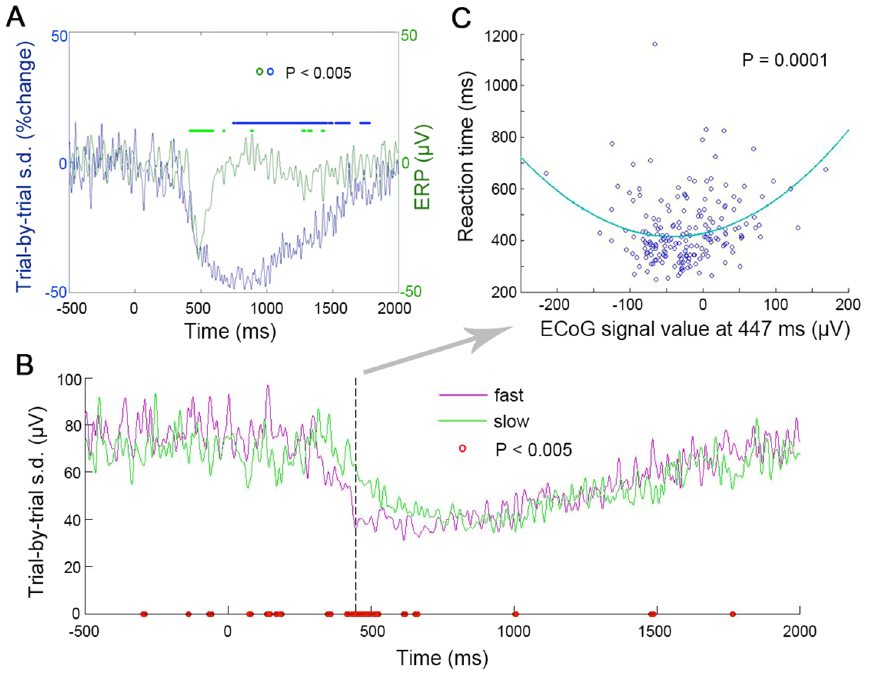
Figure 7. Inverted-U relationship between ECoG activity and response speed in an example electrode (from Pt # 3, contralateral data). ( A ) Averaged ERP (green) and across-trial variability (blue) time courses. Green and blue dots indicate P , 0.005 compared to the pre-stimulus period for ERP and variability respectively. ( B ) Across-trial variability time courses for fast and slow trials separately. Fast and slow trials were defined by a median-split on RT across all hit trials (N=195). Red circles: P , 0.005 for variability between fast and slow trials (two-sample F-test for variance). ( C ) Scatter plot of ECoG signal value at 447 ms against RT across all hit trials. Blue line indicates the best-fit quadratic function (P=0.0001).